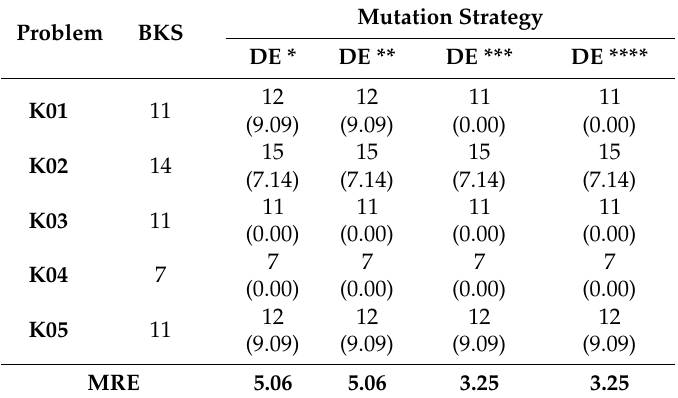
Table 14. Summary of solving the flexible job shop scheduling problem with sample problems from Kacem et al. [26,27].